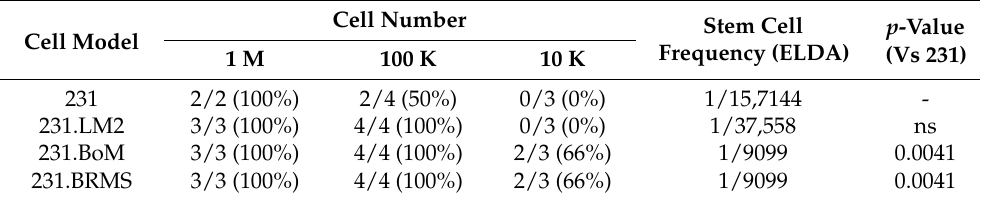
Table 2. Stem cell frequency in mice tumors. Limiting dilution data as the percentage of tumor- forming mice. The frequency of CSC was estimated using the ELDA calculating website. Confidence choice entered was 0.95, and p -values reflect differences in CSC frequencies between each of the organotropic cell lines (231.LM2, 231.BoM and 231.BRMS) and the parental cell line (231). N per group varied between 2–4 mice per group for a total of 39 subcutaneously injected